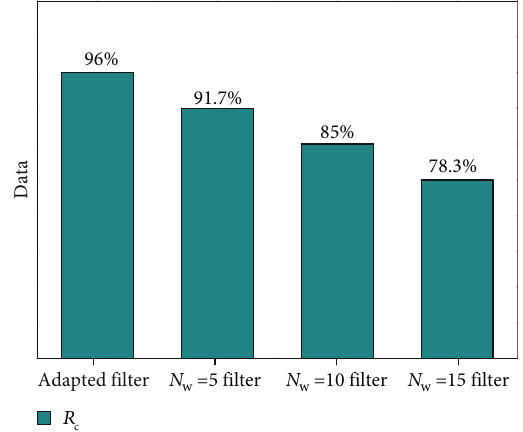
Figure 14: Comparison of the fi rst criterion is the percentage measurement of the clutter power R Ref.